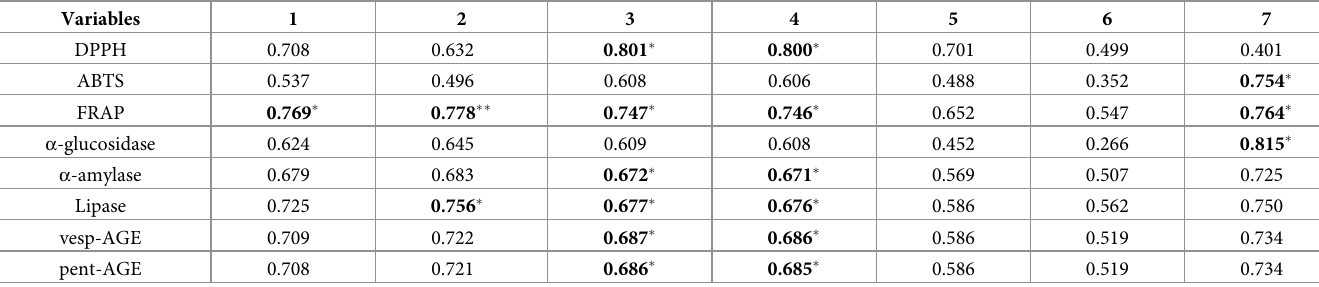
Table 3. Correlation analysis between phytochemicals and biological activities using Pearson correlation coefficient (PCC).